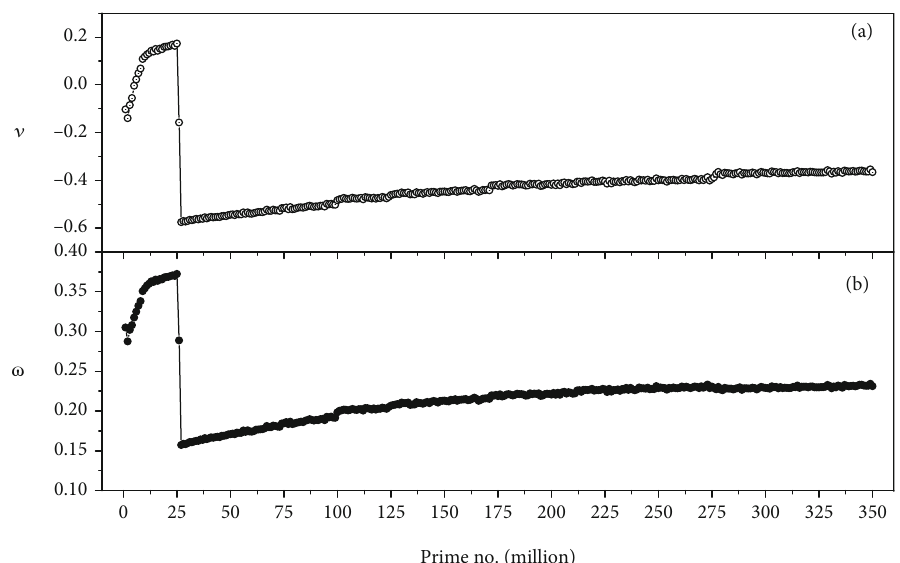
Figure 1: (a) The relation between the prime number of every million separately and the inverse χ 2 and parameter ν from one million up to 350 million primes for every million separately. (b) The relation between the prime number and Brody parameter ω from one million up to 350 million primes for every million separately.